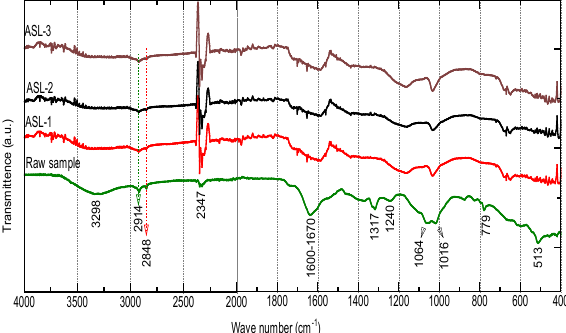
Fig. 2. FTIR spectra of raw spinach, ASL-1, ASL-2, and ASL-3